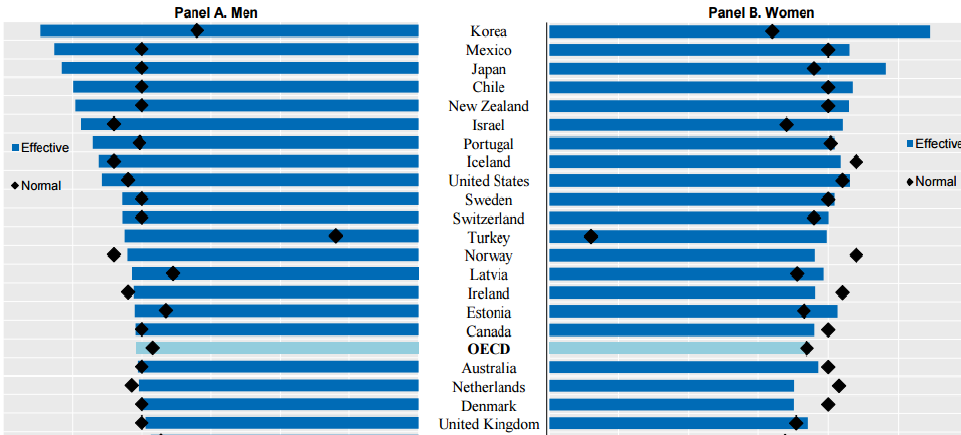
Figure 10. Average effective age of labor market exit and normal retirement age (2018). Source: OECD [6].